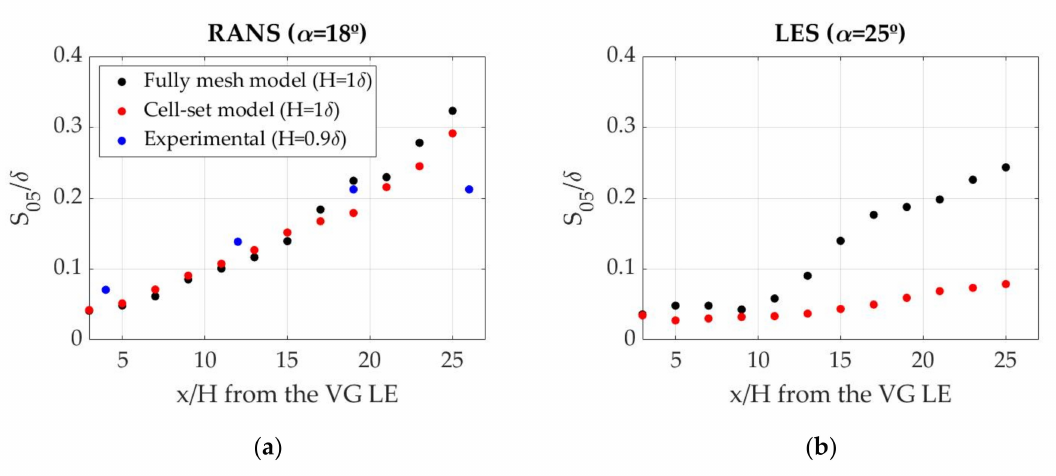
Figure 9. Half-Life Surface of the primary vortex: ( a ) RANS; ( b )